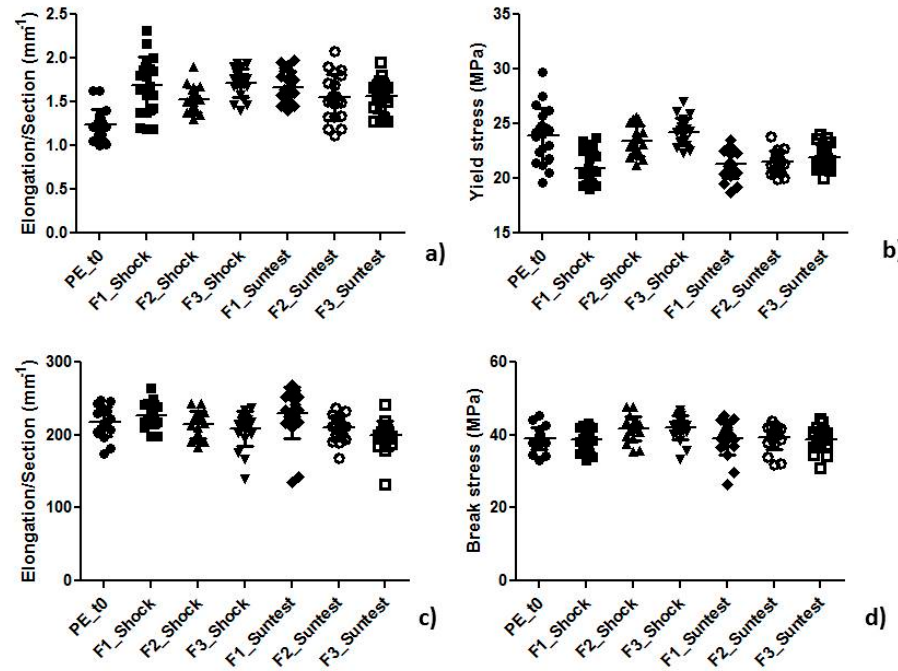
Figure 1. Example of a diagram obtained from the tensile test of the packaging.